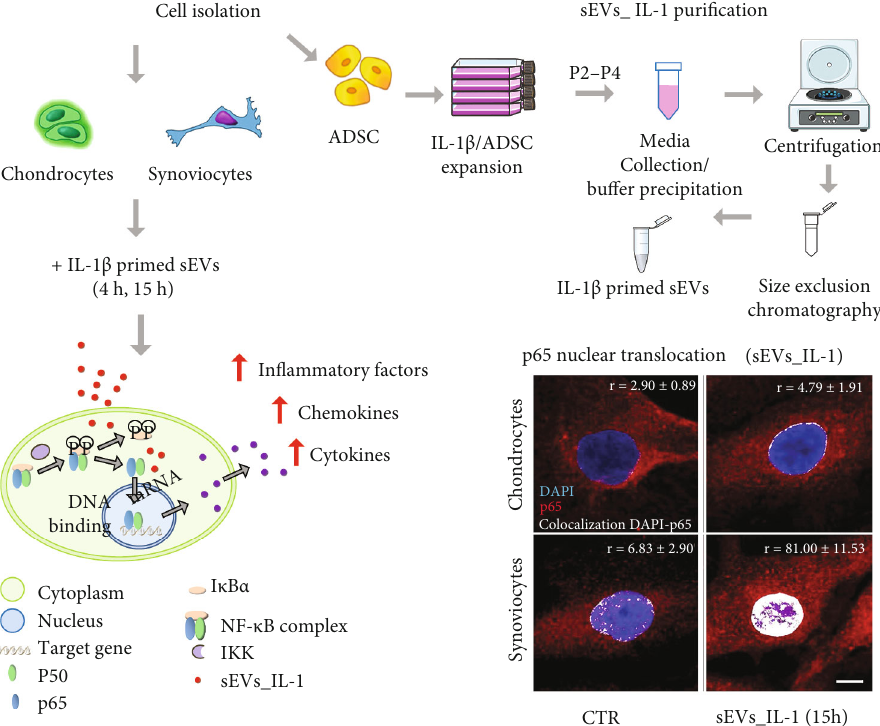
Figure 9: Experimental outline of the research work undertaken in the paper: sEVs_IL-1 collection from IL-1 treated ADSC; puri fi cation of sEVs_IL-1 through a combined precipitation and size exclusion chromatography method; addition of sEVs_IL-1 to primary cultures of chondrocytes and synoviocytes; analysis of the e ff ects at the gene and protein level and molecular hypothesis underlying the observed e ff